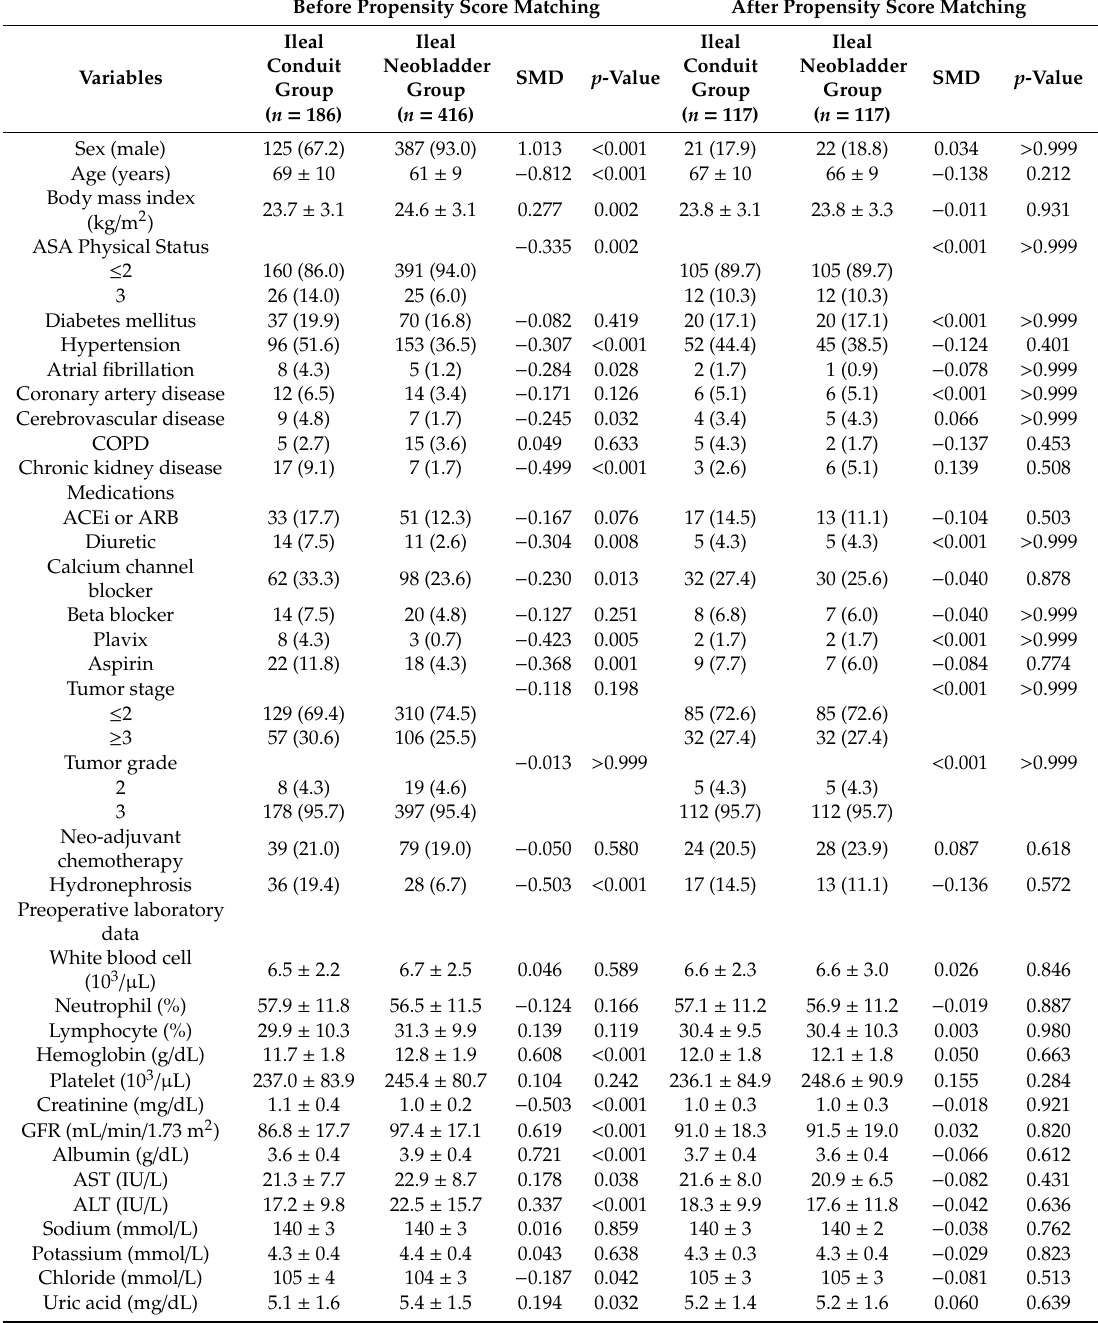
Table 1. Preoperative variables before and after propensity score